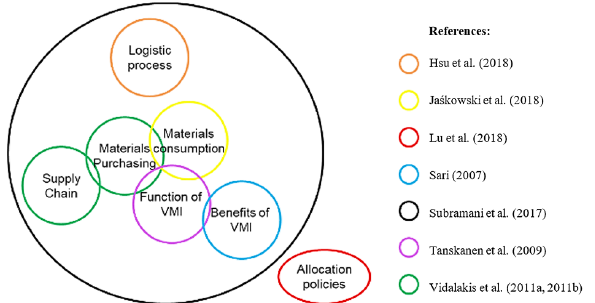
Figure 1. Synthesis of previous